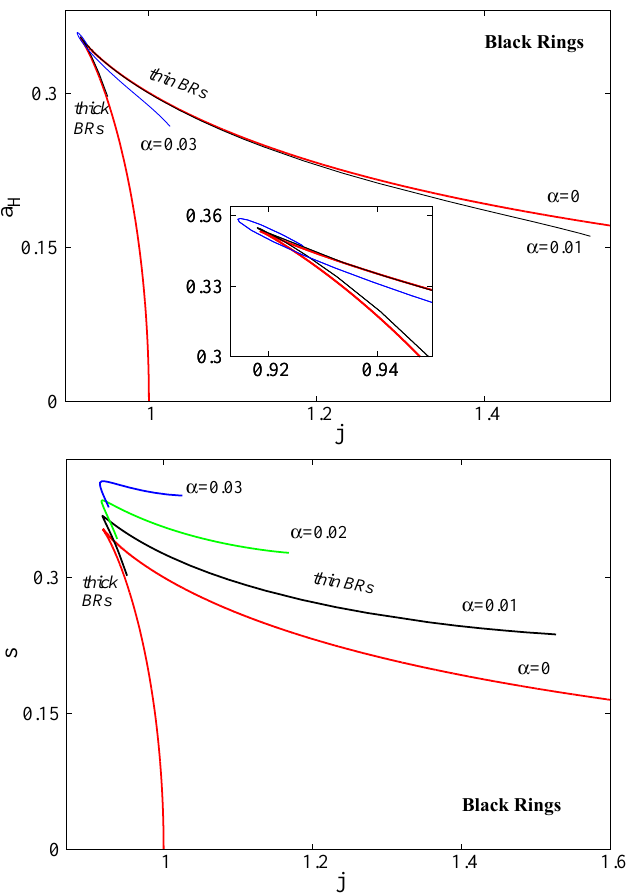
Figure 2. The reduced horizon area a H and entropy s are shown as a function of the reduced angular momentum j for balanced black ring solutions in Einstein–Gauss–Bonnet theory with several values of the GB parameter α